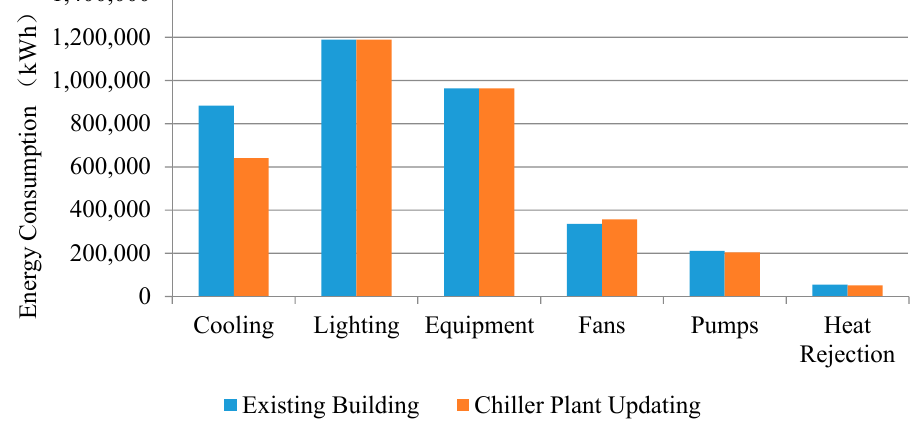
Figure 8. Annual energy consumption before and after the chiller plant upgrading.